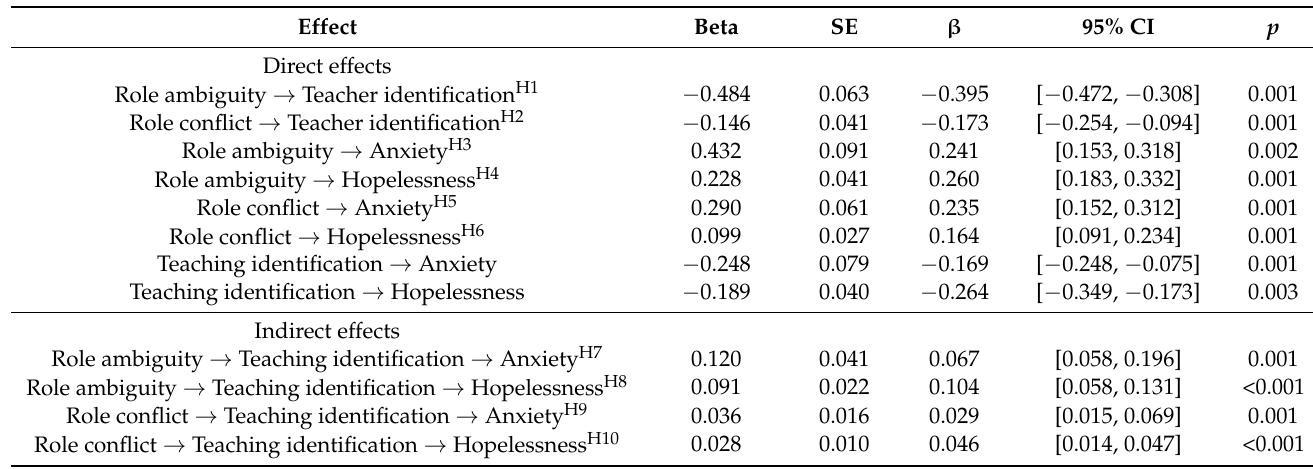
Table 3. Direct and indirect effects of role